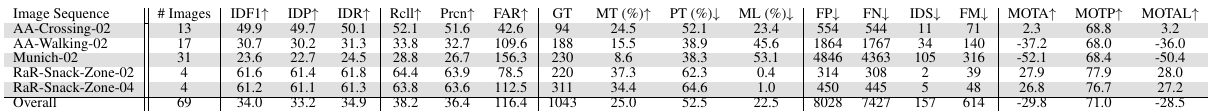
Table 4. Quantitative results of the GOT-NF-3Conv/150 model on different image sequences of the Vehicle dataset. ↑ and ↓ stand for “higher and lower is better” accordingly. ImageSequence